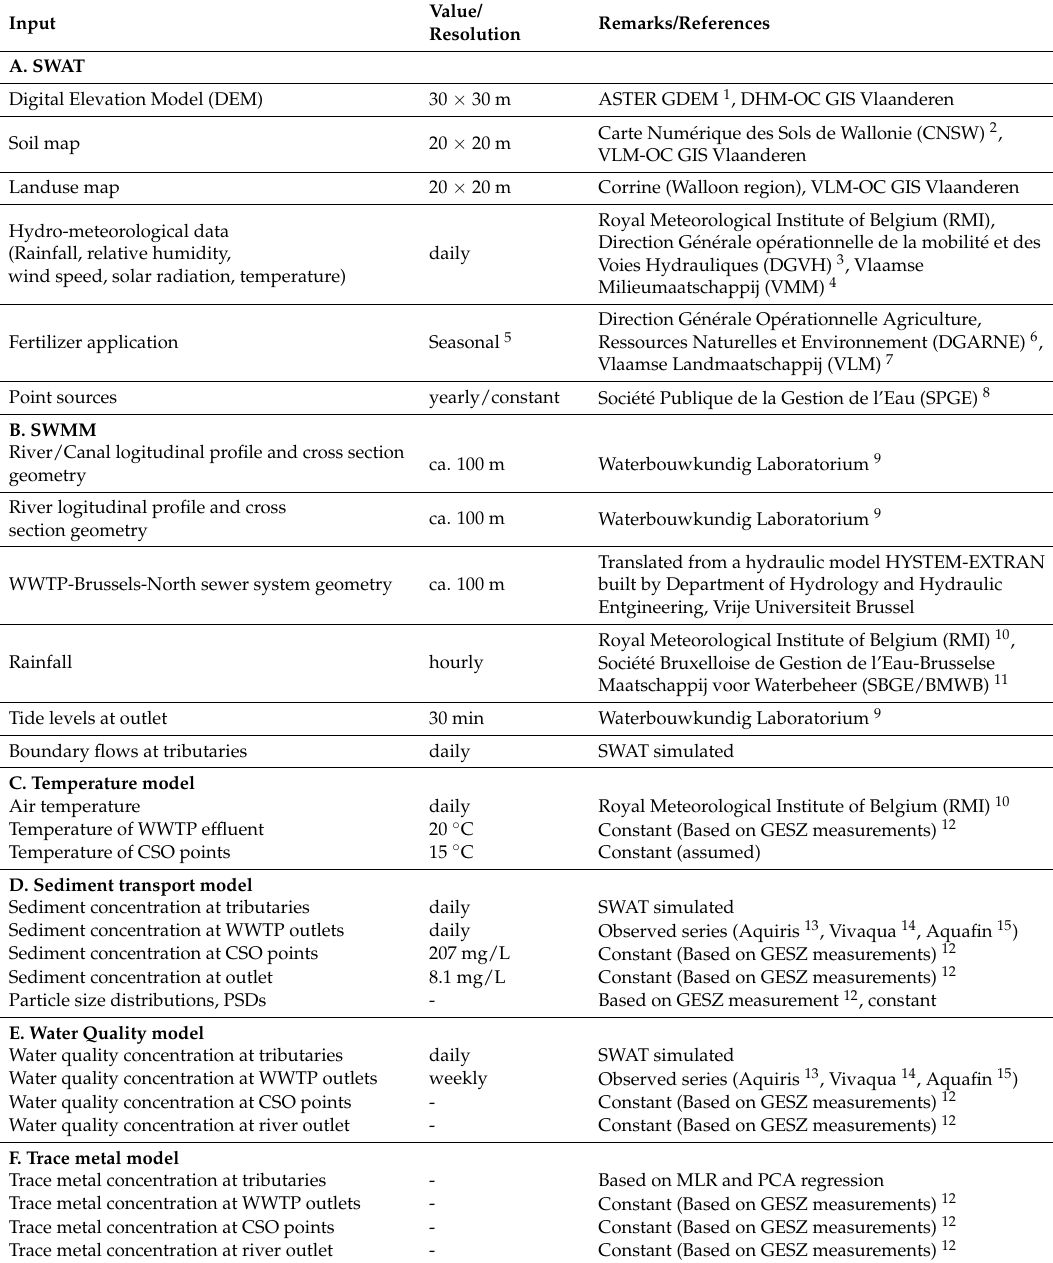
Table 2. Model inputs for the integrated